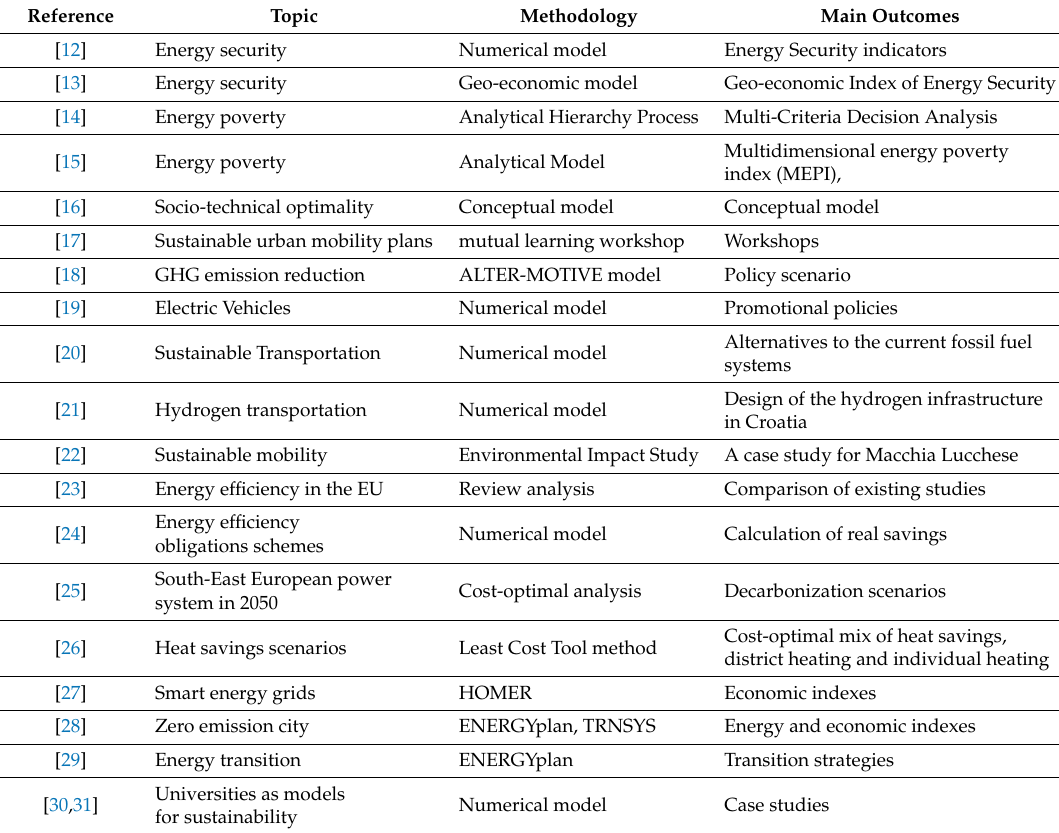
Table 1. Main topics, methodologies and outcomes of the previous SDEWES papers dealing with energy policy and energy efficiency in smart energy